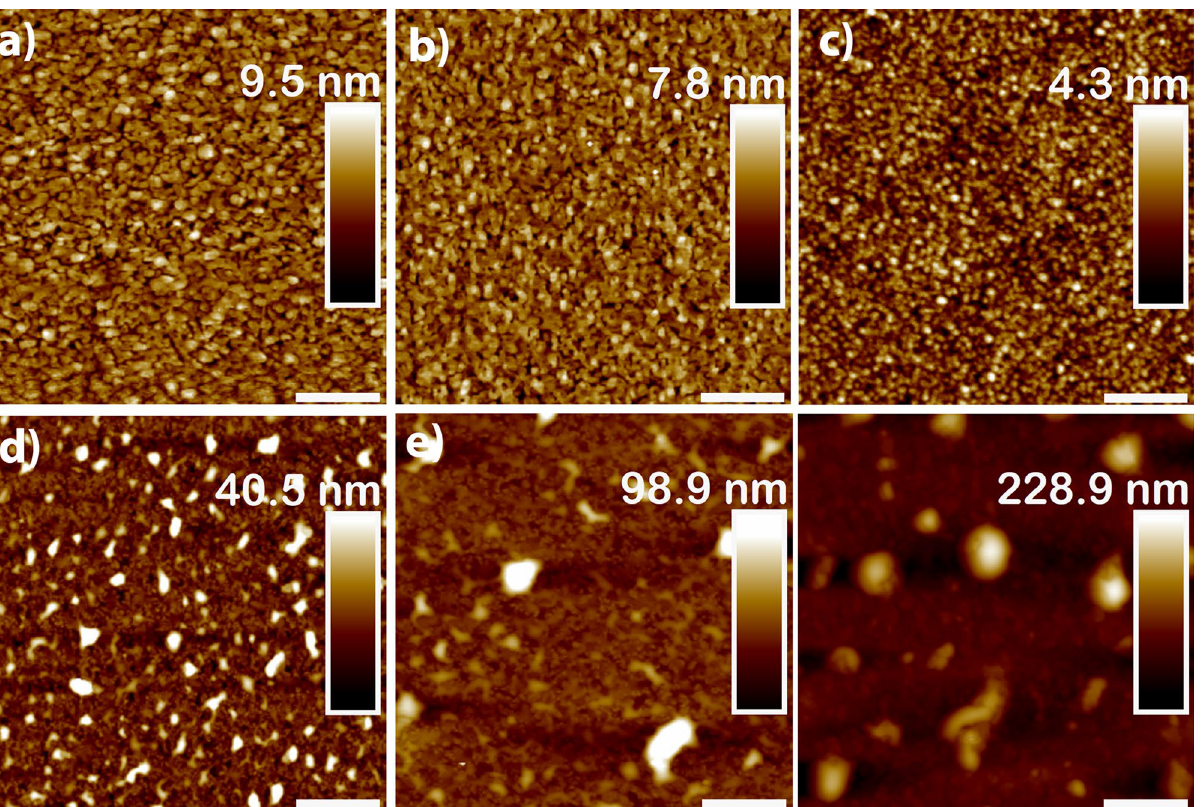
Figure 3. AFM images of Si x Ge 1 − x O 2 thin films thin films grown on Y-cut quartz substrates, with ( a ) x = 0, ( b ) x = 0.08, ( c ) x = 0.16, ( d ) x = 0.20, ( e ) x = 0.21 and ( f ) x = 0.48. Note the columnar features growing in number and height with increasing Si content. Scale bar is 600.0 nm for the first row and 2.0 μm for the second row.